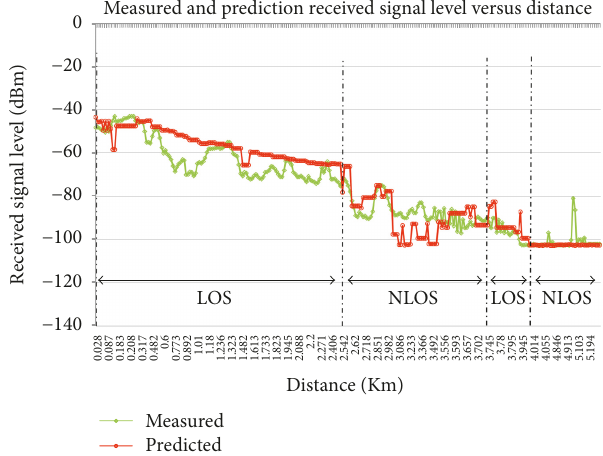
Figure 8: Measured and predicted signal level versus distance.